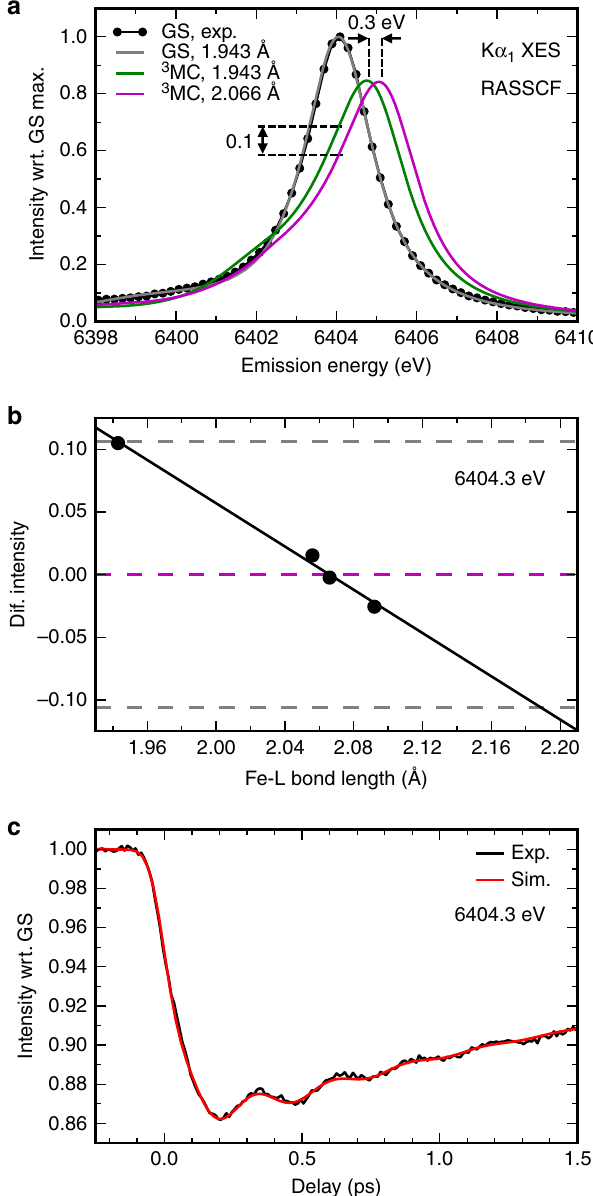
Fig. 6 Simulated K α XES signals. a Experimental XES spectra of the [Fe(bmip) 2 ] 2 + ground state (GS, black dots), compared with the calculated GS spectrum (gray line) and the 3 MC excited state spectra at the GS geometry (green line) and at the 3 MC geometry (magenta line). b Calculated 3 MC state XES intensity change at 6404.3 eV as a function of the Fe-ligand (L) bond length, relative to the optimal 3 MC structure (black dots; black line: linear fi t). Dashed lines correspond to the intensity changes at optimal (magneta) and extremal (gray) bond lengths, R = 2.066± 0.123 Å. c Simulation of K α XES time-dependent intensity at 6404.3 eV (black line: experiment; red line: